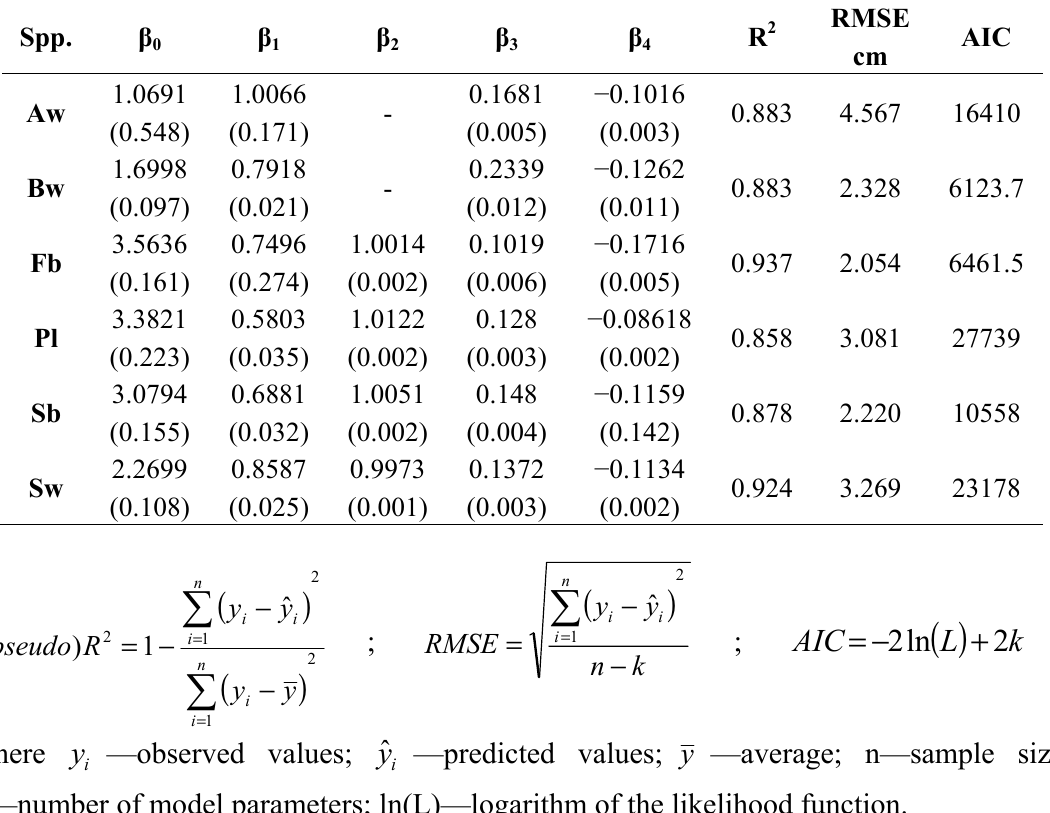
Table 4. Parameters estimates (reported with standard errors) and goodness-of-fit for tree diameter modeled as a function of height, crown area, and basal area of the larger trees, for trembling aspen and white birch Equation (6); and for balsam fir, lodgepole pine, black spruce and white spruce Equation (7), as described in Section